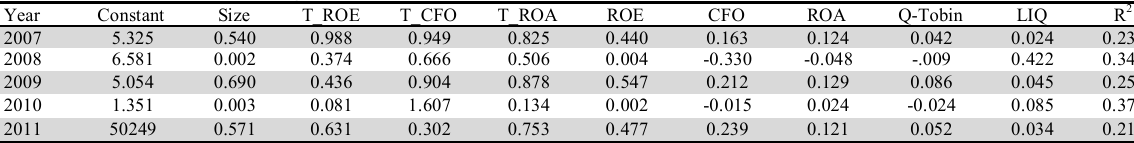
Multi-variables Linear-regression